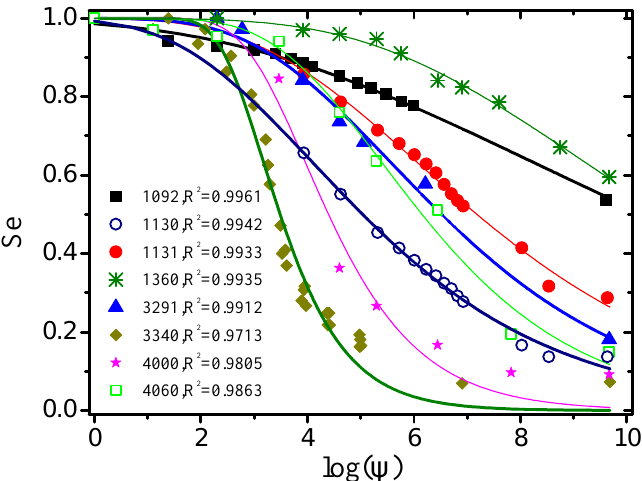
Figure 26. Curve fitting of experimental data from UNSODA by new general soil-water characteristic function derived in this study (numbers such as 1092 represent the sample number in